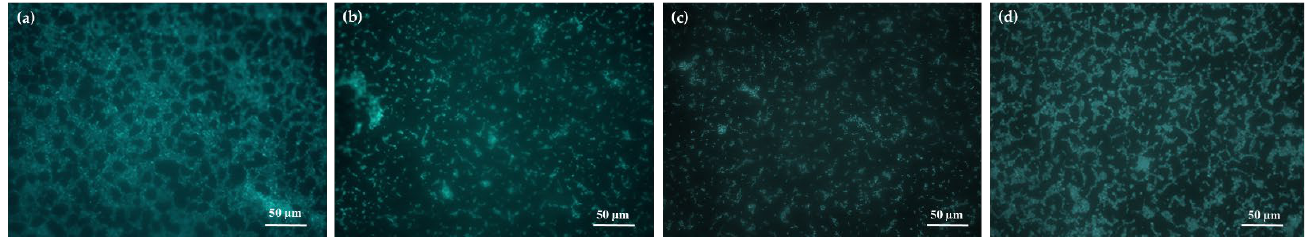
Figure 22. Images of microbial biofilm present on coating surfaces after 60 days of experimentation seen after DAPI staining under fluorescent microscopy (EM); ( a ) G_A, ( b ) G_A_F3, ( c ) G_A_F16, and ( d ) G_A_F3_F16.